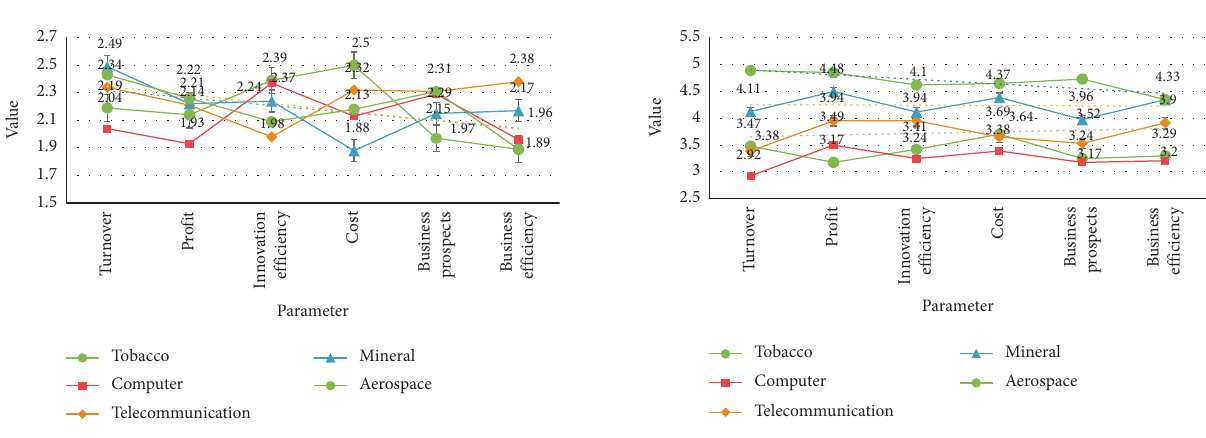
Figure 8: The parameters before the change. Figure 9: The parameters after the